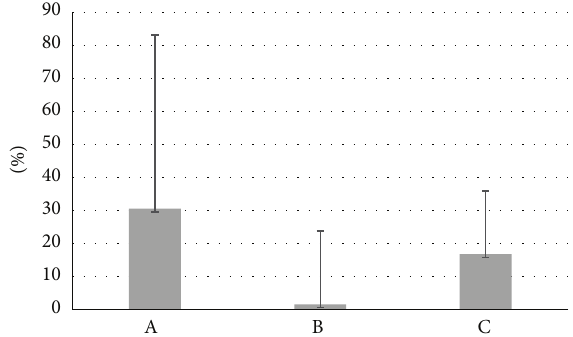
Figure 2: Difference of progressive motility in fresh samples. Values areshownasmean ± SD.A:freshsampleandthesampletreatedwith Myo-Ins. B: fresh sample after capacitation and sample treated with Myo-Ins after capacitation. C: fresh sample after capacitation and sample treated with Myo-Ins after